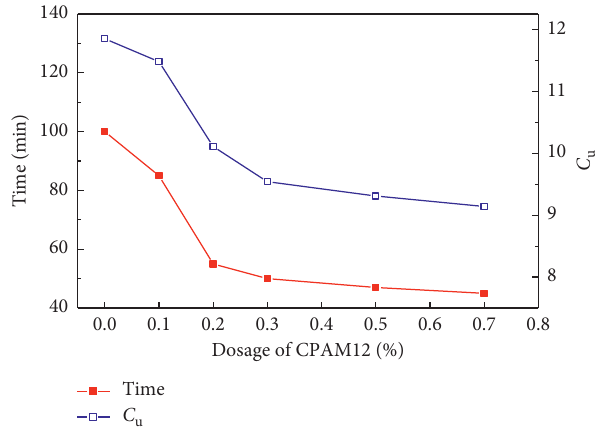
Figure 15: Change curves of the time required for pressure fil- tration to reach stability and of the nonuniformity coefficient for different dosages of CPAM12.